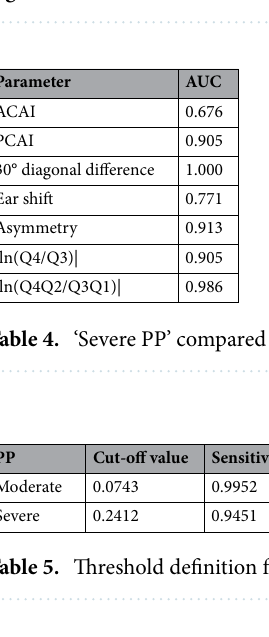
Figure 7. ROC curves for ‘severe PP’ compared with those of ‘no + moderate PP’.